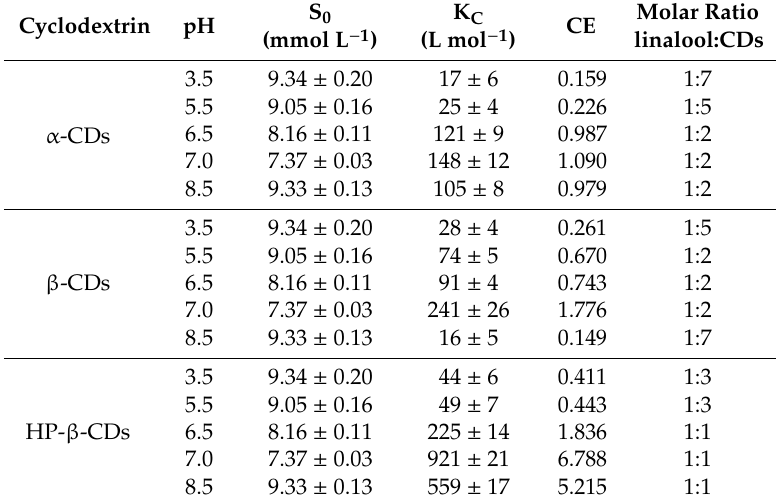
Table 1. Recovery aqueous solubility (S 0 ), complexation constant (Kc), complexation e ffi ciency (CE) and molar ratio of linalool for α -, β - and HP- β -CDs at di ff erent pH values. Standard deviation of triplicate